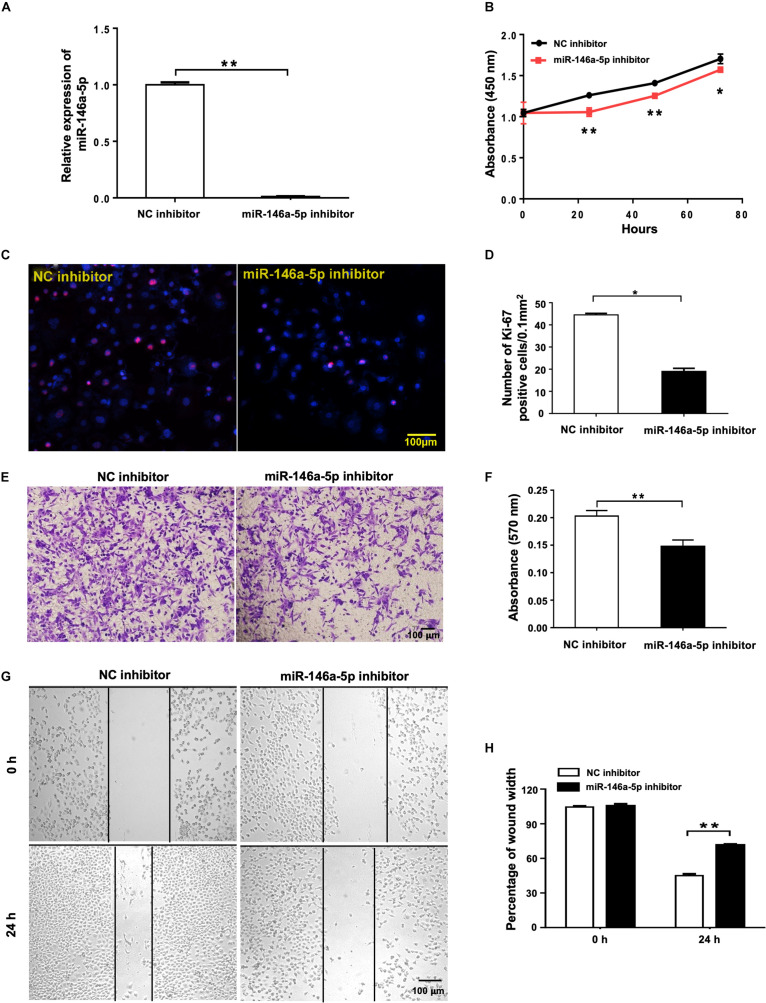
miR-146a-5p inhibitor suppresses cell proliferation and migration in NSCLC cells. Cell proliferation and migration measurement of H1299 cells at 24 h post transfection of miR-146a-5p inhibitor or NC inhibitor. (A) The mRNA expression of miR-146a-5p measured by qRT-PCR. (B) Cell proliferation examined by CCK-8 assay. (C) Cell proliferation measured by Ki-67 staining. (D) Quantification of the Ki-67 staining assay result of (C). (E) Migration ability measured by transwell assay. (F) Quantification of the transwell assay result of (E). (G) Migration ability detected by wound-healing assay. (H) Quantification of the wound-healing assay result of (G).